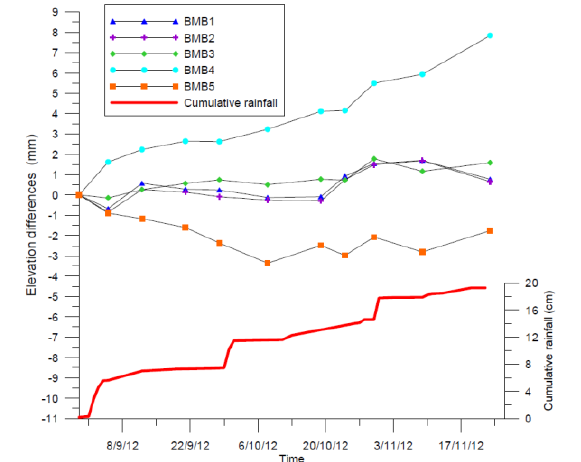
Figure 12. Elevation differences for benchmarks fixed in masonry of old buildings at unknown foundation depth, with respect to first epoch.